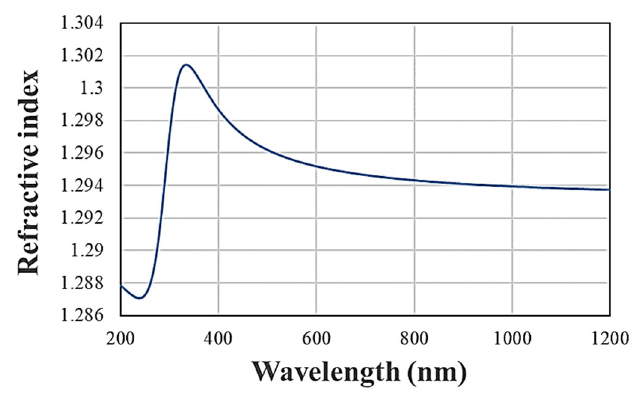
Figure 3. Refractive index as a function of the wavelength for the silica-based coating.